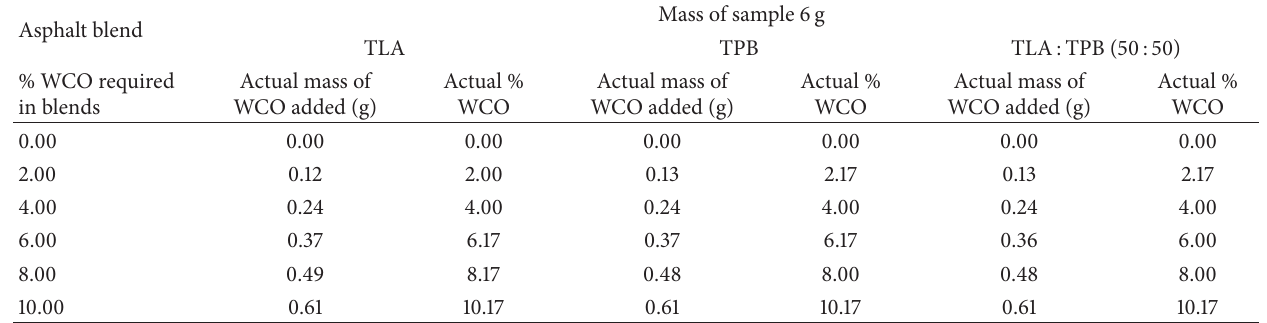
Table 1: Concentrations of sample blends.